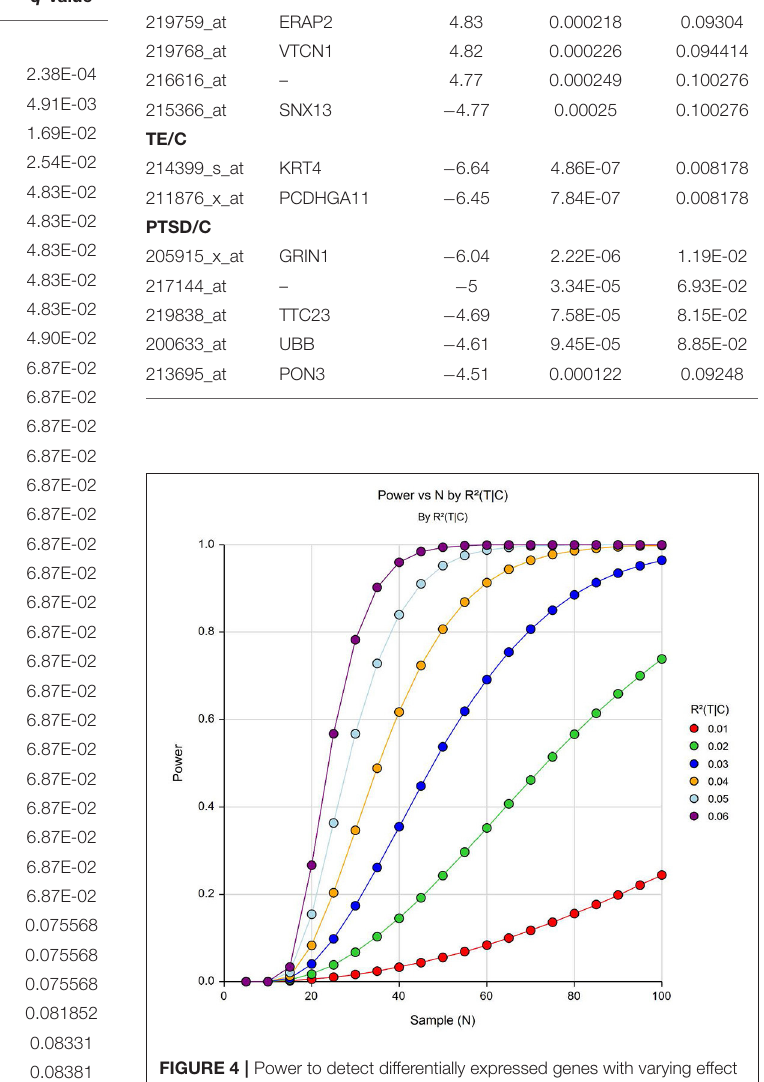
TABLE 2 | Significant single gene expression analyses between the different comparisons at an FDR of 10%. Probeset ID